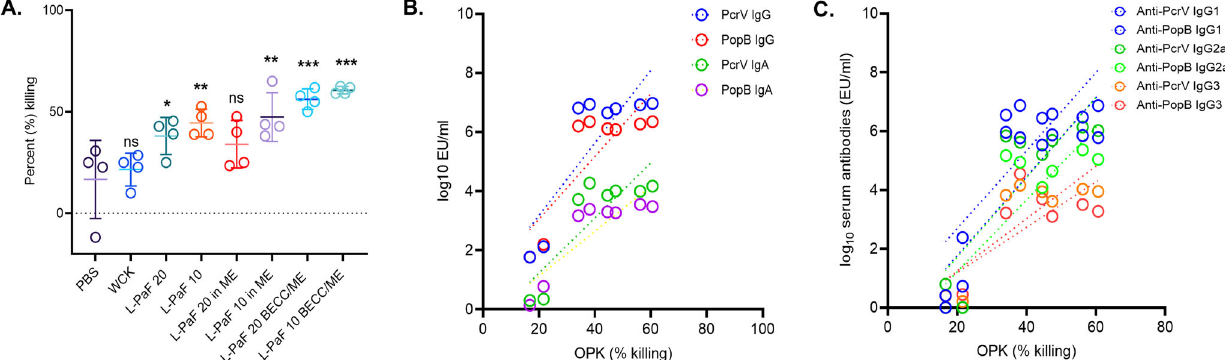
Fig. 2 Serum immunoglobulins possess opsonophagocytic killing (OPK) activity. The day 42 sera from Fig. 1 were heat-treated at 56 °C for 30 min for subsequent use in OPK assays. A Relative OPK activities are shown for sera collected from each CD-1 mouse group are shown. B A correlation between OPK and either anti-PcrV or anti-PopB immunoglobulin titers is shown. C A correlation between OPK and speci fi c subclasses of IgG against PcrV and PopB is shown. The points in ( A ) represent individual OPK values obtained from the experiment (error bars represent SD for each group), whereas the points in ( B ) and ( C ) represent correlation values obtained between OPK and pooled D42 serum. Pearson ’ s r coef fi cient and simple linear regression (95% con fi dence level) were calculated for ( B ) and ( C ). * p < 0.05, ** p < 0.01, *** p < 0.001. Exact p values can be found in Supplementary Tables 1, and